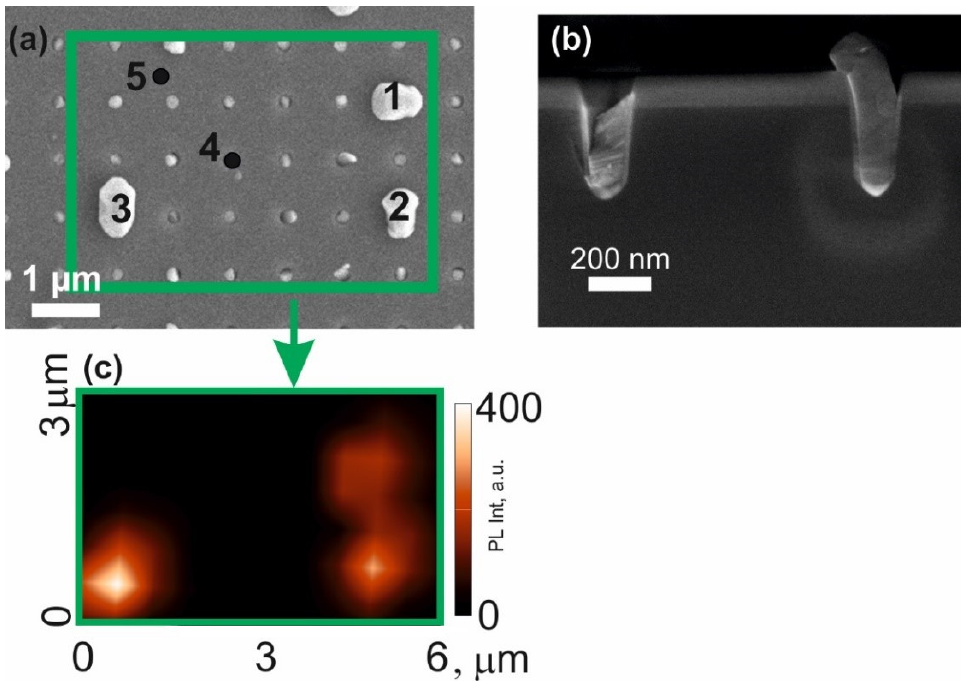
Figure 2. ( a )—SEM obtained from the top of sample S1; ( b )—SEM image of the cross-section of the sample S1; ( c )—map of the distribution of photoluminescence intensity in the spectral range from 800 to 1650 nm in the area of the sample marked with a rectangle in ( a ) .